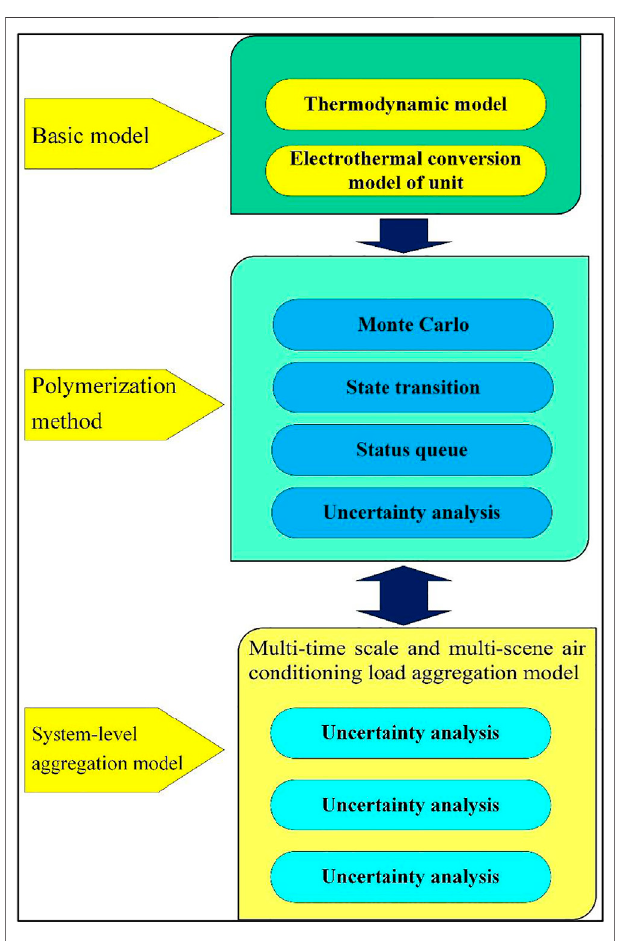
FIGURE 2 | The framework of air conditioning load